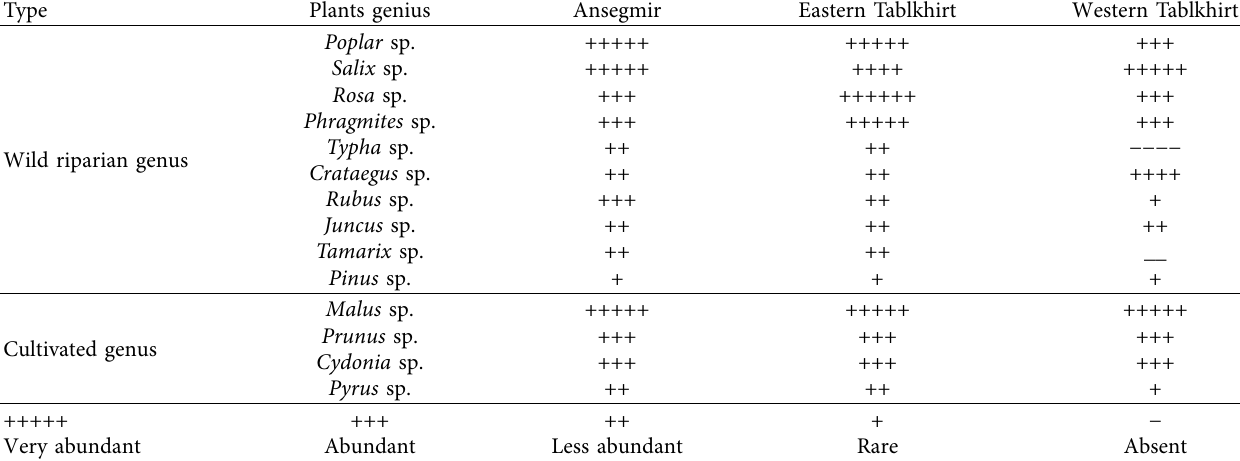
Abundant Less abundant